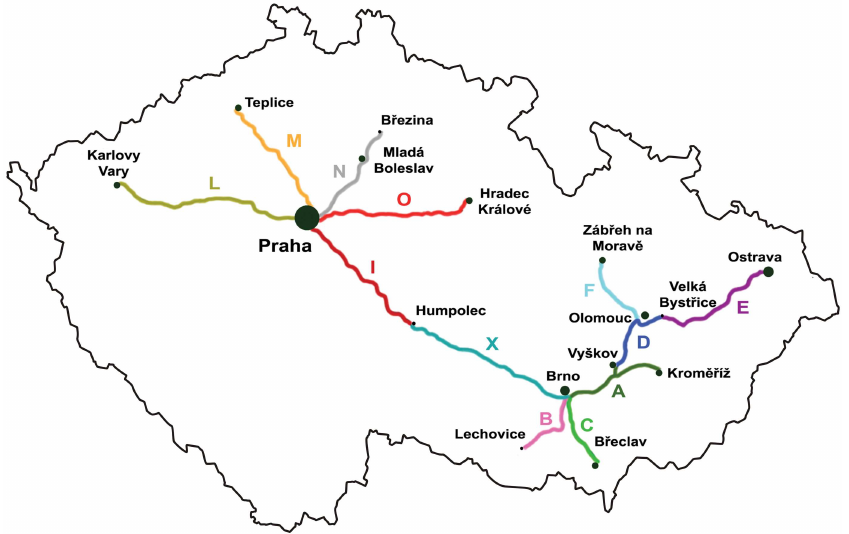
Fig 3. Localities of Blumeria graminis f. sp. hordei collection in the Czech Republic. The country is dividedinto sub-regionscorresponding to highwayspassingthrough main barley growingareas. Each sub- regionis labeledas color line and marked with different letter. The letters correspondsto isolate designations in S5 Table. Numbers of isolates collectedin individualsub-regionsare as follows: A (12), B (6), C (12), D (5), E (15), F (3), I (15), L (2), M (6), N (4), O (3), X